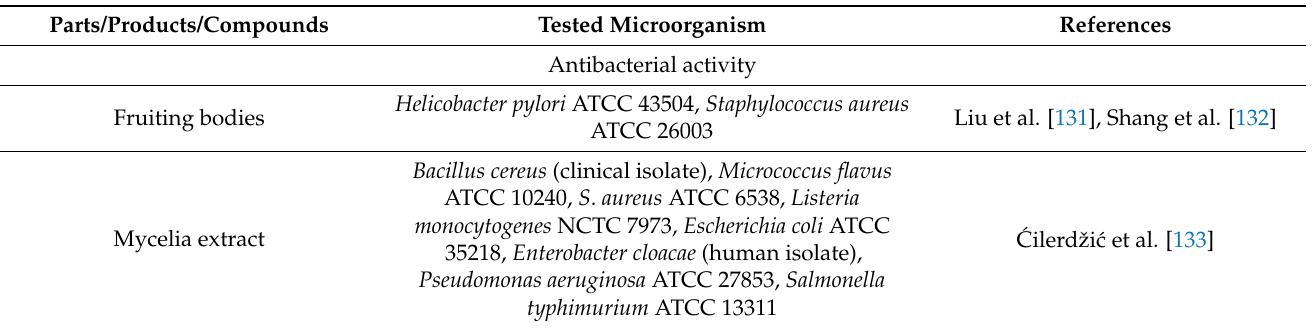
Table 4. Antimicrobial activities of Ganoderma lucidum parts, products, and